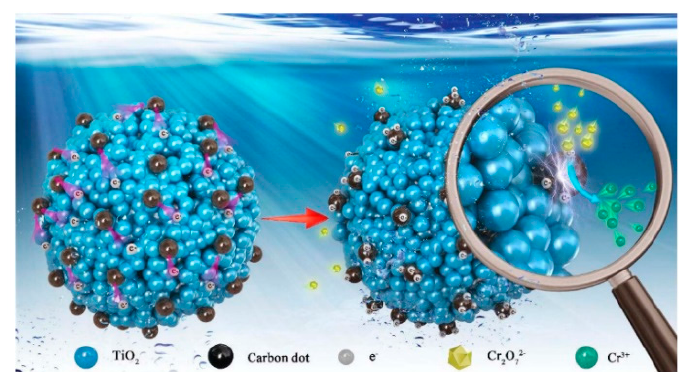
Figure 3. Adsorption–photoreduction–desorption mechanism of Cr(VI) in the presence of the CDs/MT composite. Reprinted with permission from [63]. Copyright 2018, Elsevier.